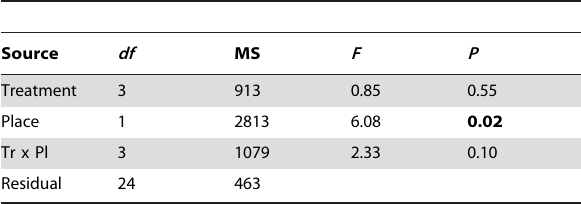
Table 1. Analysis of survival (%) of Phyllospora five months after the second experimental transplant.